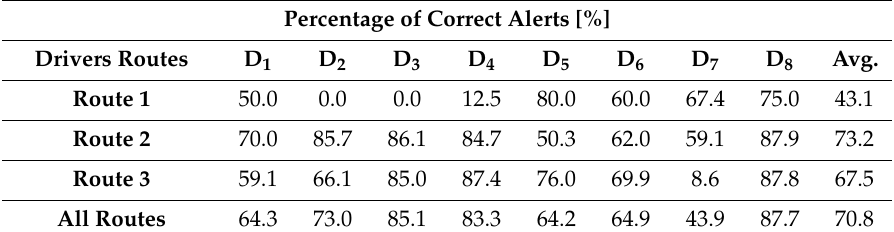
Figure 16. Average total risky maneuvers on all routes for V 2 ( Heavy Vehicle ). Table 7. Decrement percentage of risky maneuvers for V 2 (Heavy Vehicle): Route 1, Route 2, Route 3 and all routes.